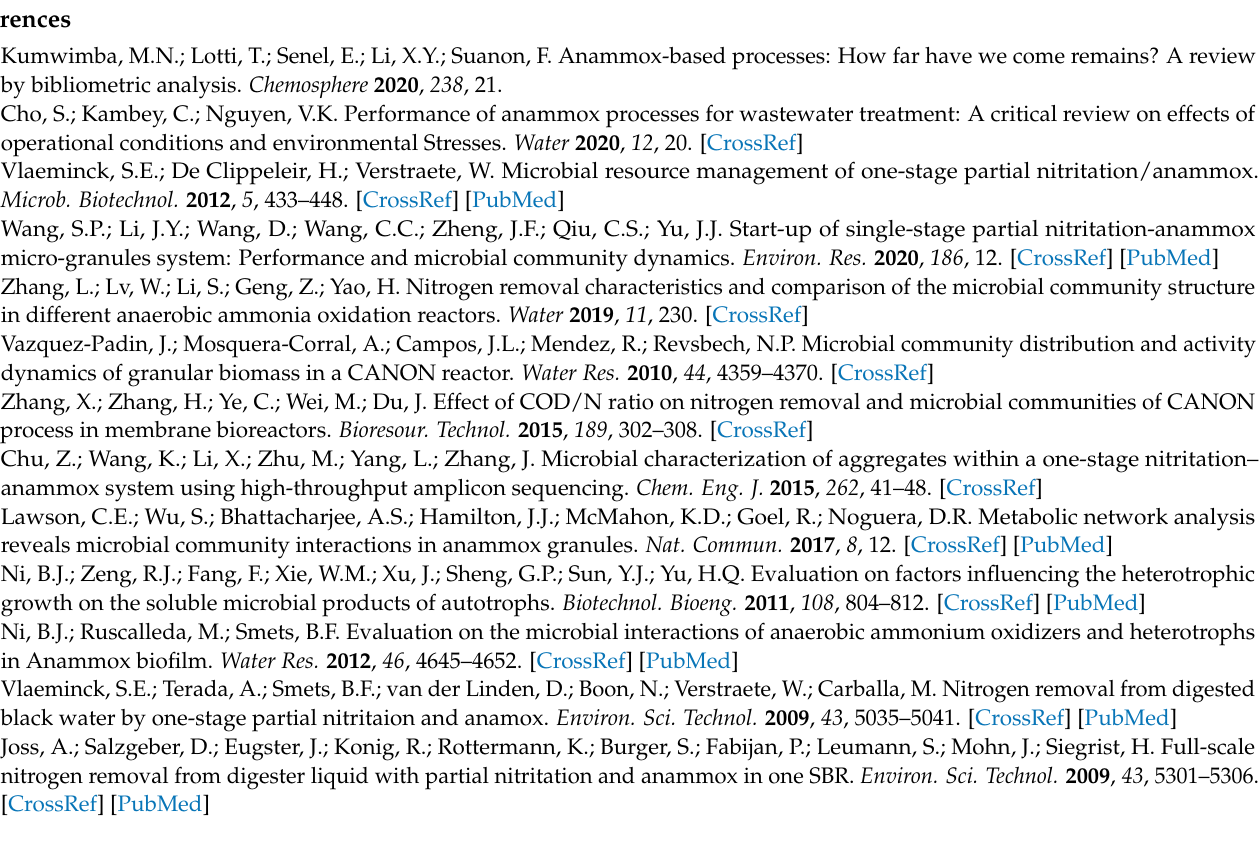
model. Table S4: Kinetic rate expressions for bioconversion processes in the model. Table S5: Kinetic and stoichiometric parameters for bioconversions used in the model. Figure S1: Schematic representation of the mode set-up in